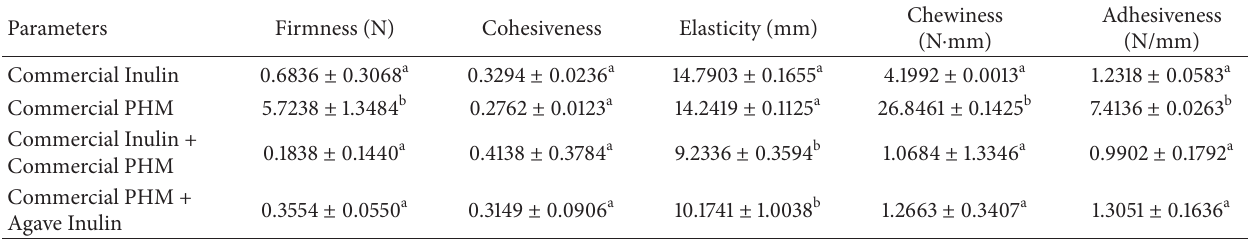
Table 5: Texture parameters of different prepared gels with inulin and commercial high-methoxy pectin (PHM).